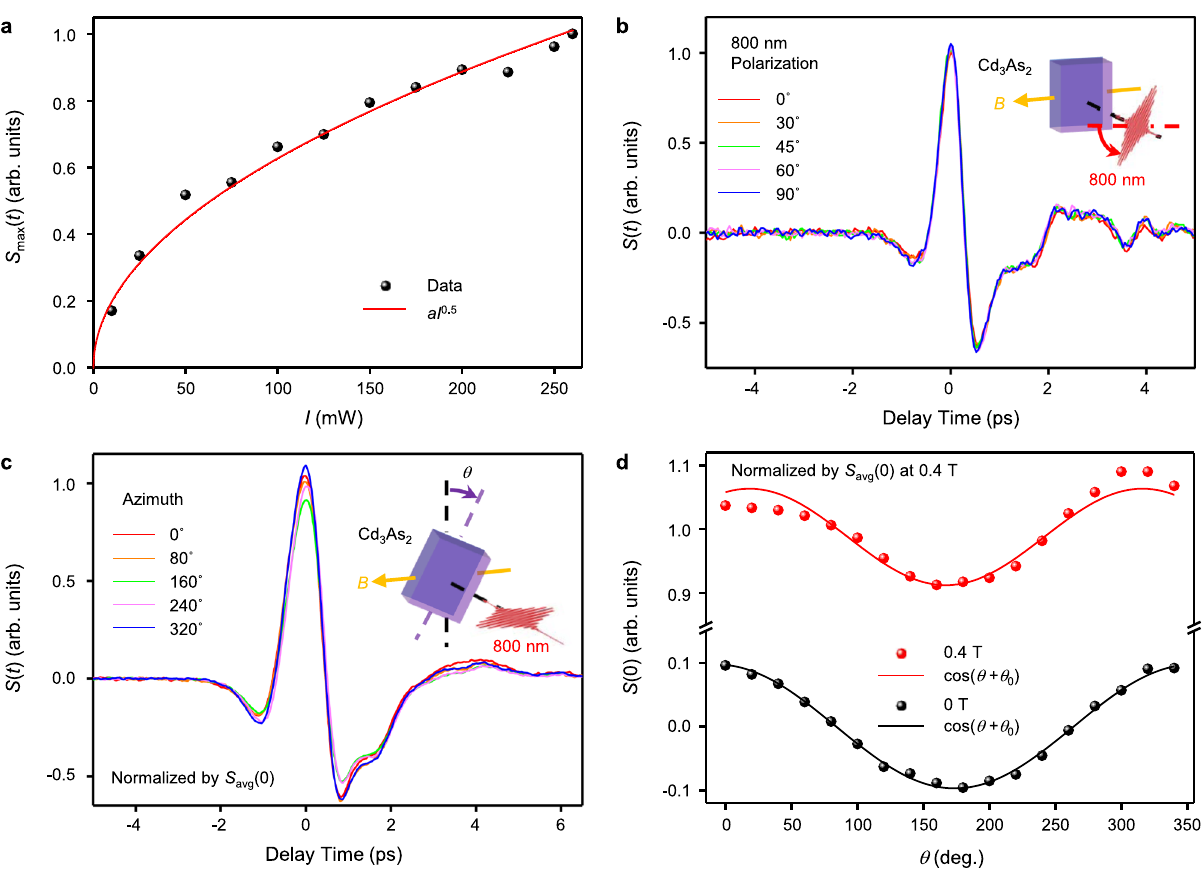
Fig. 3 THz emission from Cd 3 As 2 with a magnetic fi eld of ~0.4 T at x -direction. a The laser intensity dependence of the peak fi eld of emitted THz pulse. The red line is a power-law fi tting. b Typical THz waveforms excited by laser with different polarization. c Typical THz waveforms at different azimuthal angle θ . d The azimuthal angle dependences of the peak fi eld of THz pulses with and without magnetic fi eld, and the lines are the cosinoidal fi tting. The data are normalized by the average amplitude at time zero ( S avg (0), 0.4 T). Insets in panels ( b , c ): the schematic illustrations of the corresponding